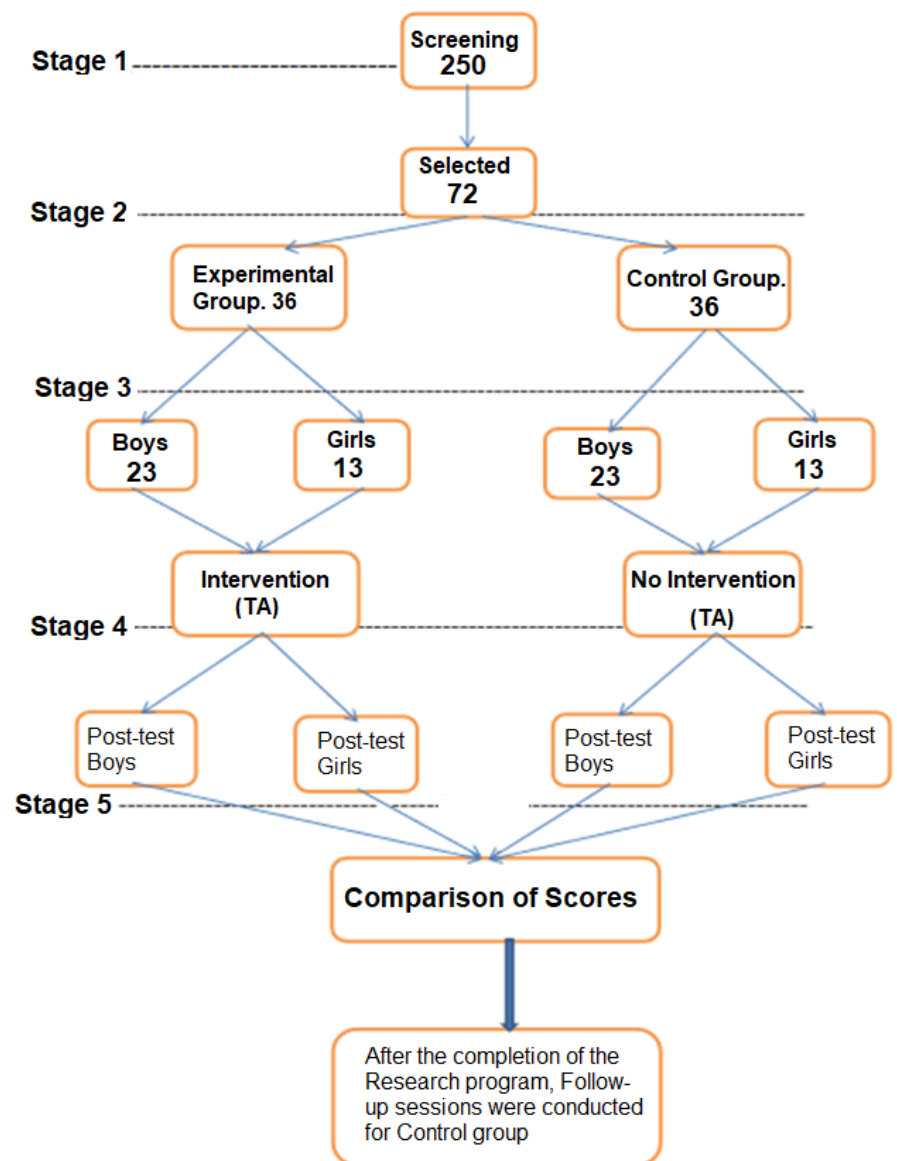
Figure 2: Schematic Representation of the Research Design